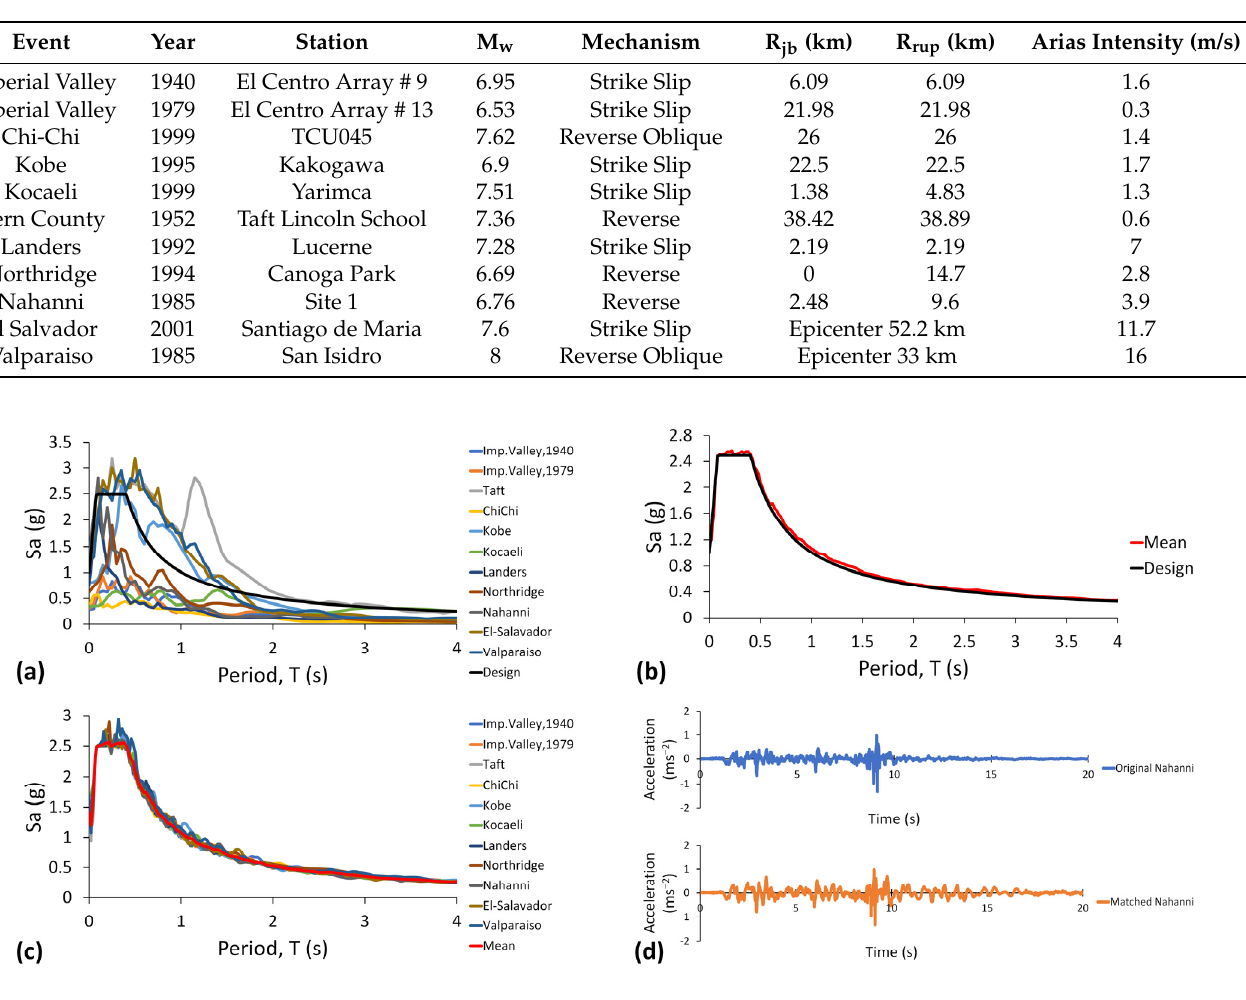
Figure 1. Spectral acceleration: ( a ) spectra before matching, ( b ) mean spectral matching, ( c ) spectra after matching, and ( d ) time history of Nahanni .